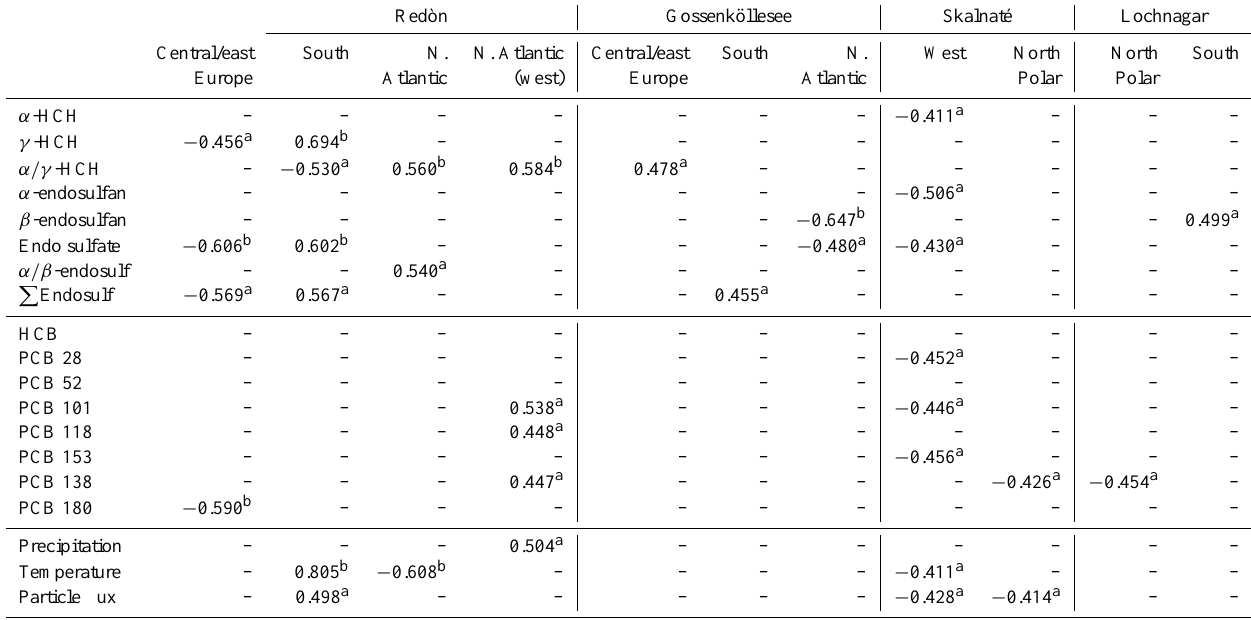
Table 6. Pearson correlation coefficients between OC deposition fluxes and % of air masses from different origins at the study